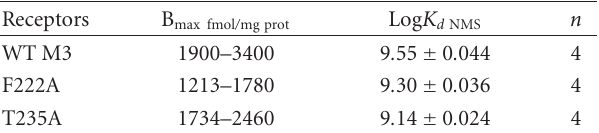
Table 2: Determination of the Log a ffi nity and B max values of M 3 WT receptor and mutant receptors: F222A and T235A. The a ffi nity constants and ranges of Bmax values of 3 H NMS at M3 WT and mutant receptors F222A and T235A expressed in COS-7 cells are shown as the log values ± standard